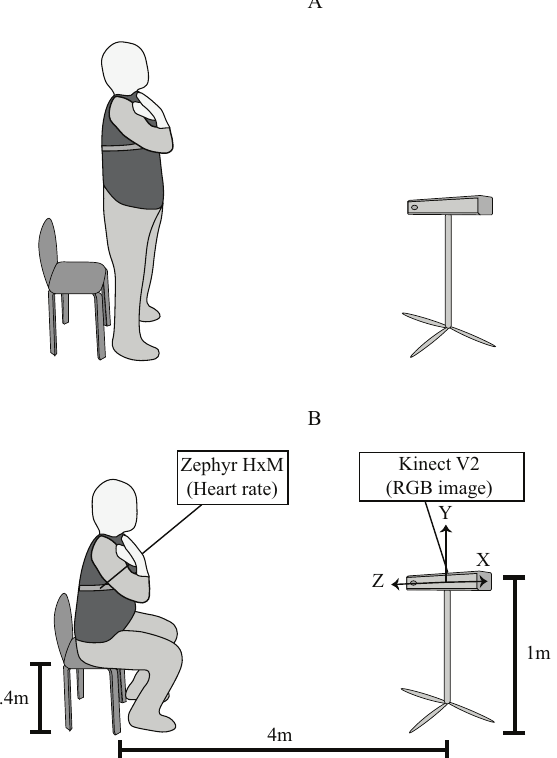
Figure 1. Set-up of the study and sit-to-stand representation, ( A ) standing position and ( B ) sitting